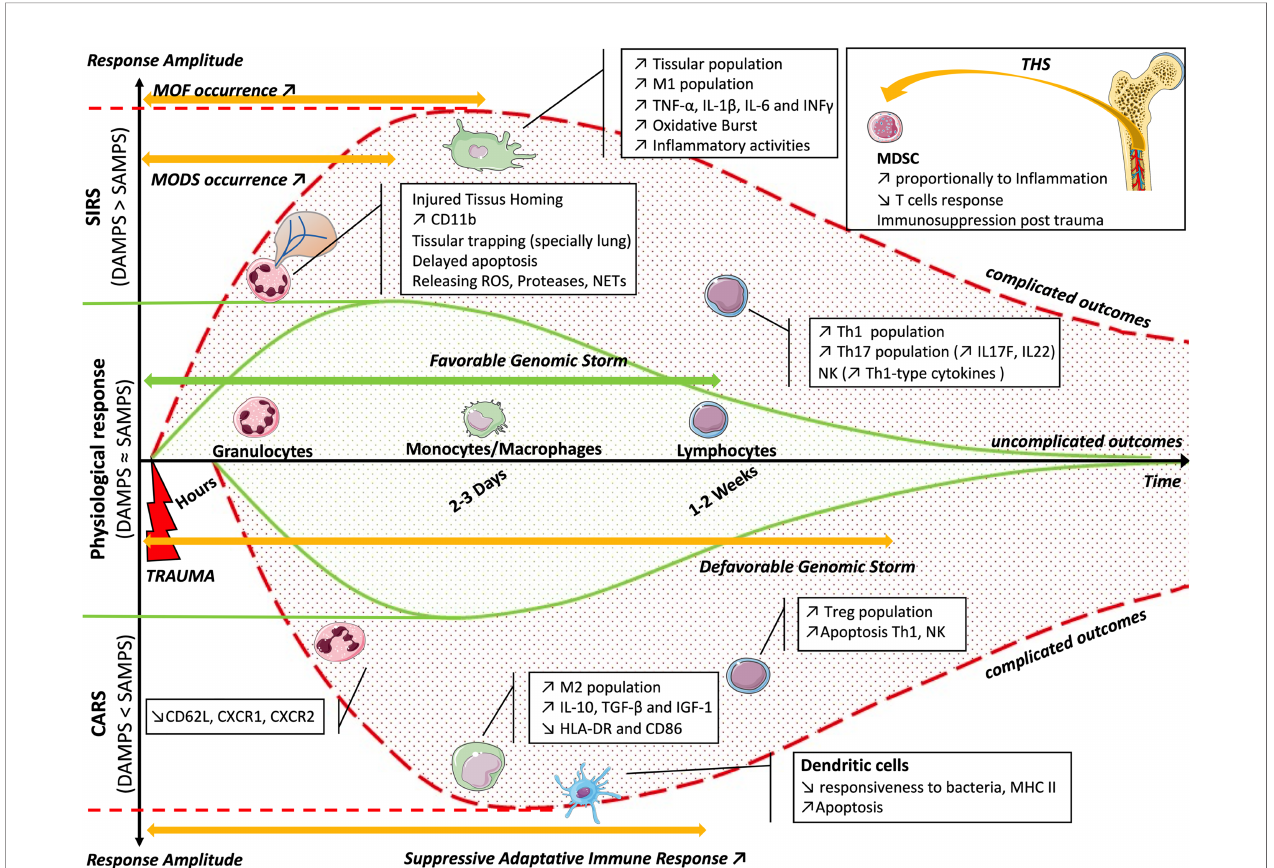
FIGURE 2 | Balance of the in fl ammatory reaction (CARS or SIRS) as a function of time. The solid green curves represent the physiological response, following the favorable genomic storm and the balance between the effects of DAMPs and SAMPs. In the case of imbalance, the genomic storm becomes unfavorable. The upper dotted red curve represents the imbalance toward SIRS, with an increased effect of DAMPs, appearance of MODS and MOF, and cellular modi fi cations. The lower dotted red curve represents the imbalance toward CARS, with an increased effect of SAMPs, appearance of suppressive adaptive immune response, and cellular changes. The box summarizes bone marrow dysfunction during THS. CARS , counterbalancing anti-in fl ammatory response syndrome; SIRS , systemic immune response syndrome; DAMPs , damage-associated molecular patterns; SAMPs , suppressing inducible DAMPs; MODS , multi-organ dysfunction syndrome; MOF , multi-organ failure; THS , traumatic hemorrhagic